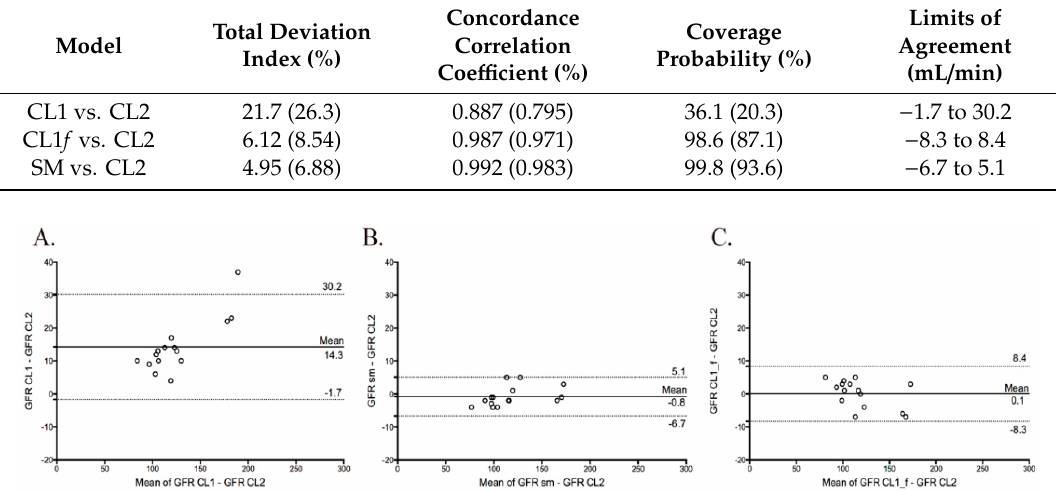
Table 2. Agreement analysis between GFR values measured with the one-compartment model with (CL1 f ) and without (CL1) an adjustment formula, or the simplified method (SM) with the two-compartment model CL2.